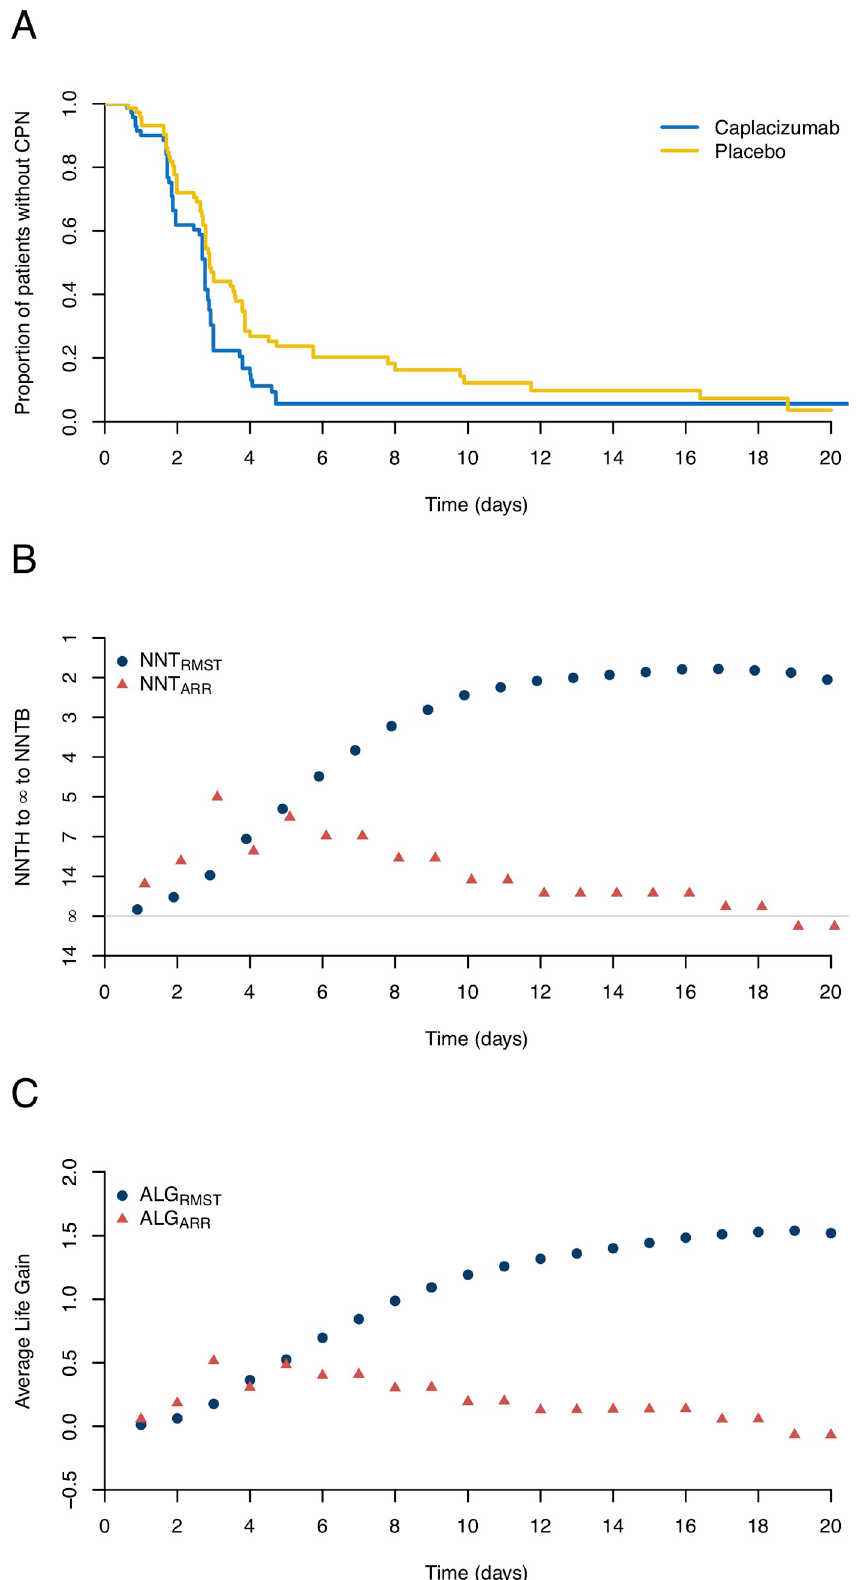
Fig 3. Estimated survival curves, numbers needed to treat (NNTs), and the average life gain (ALG) based on the reconstructed data from the caplacizumab trial. (A) Kaplan-Meier curves for the caplacizumab and placebo groups.